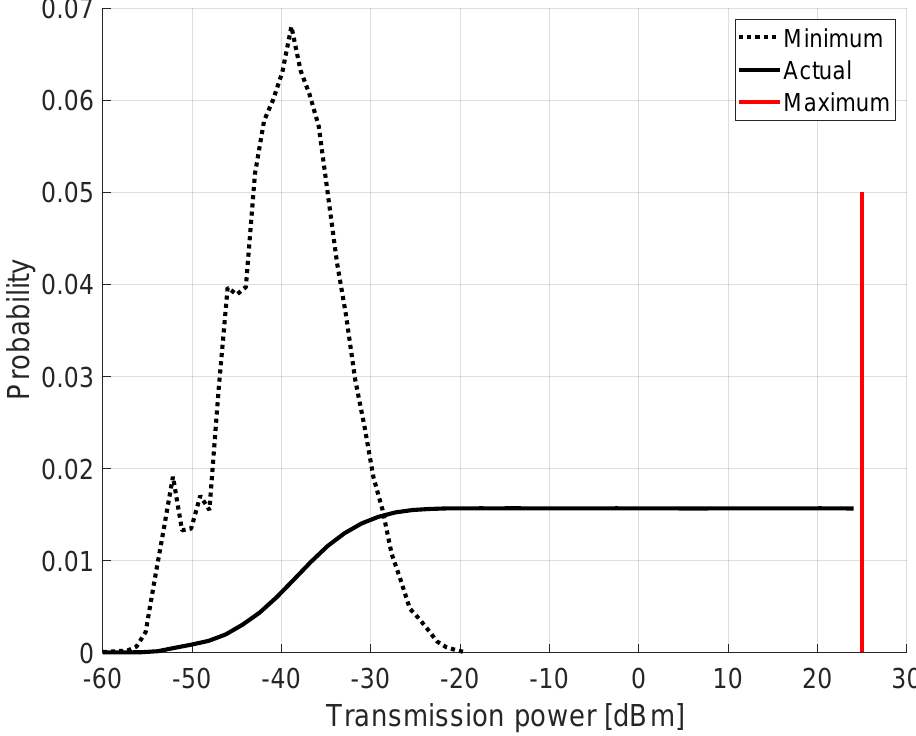
Figure 3. Power-modulated jammer: the minimum transmission power is opportunistically chosen in order cover the whole